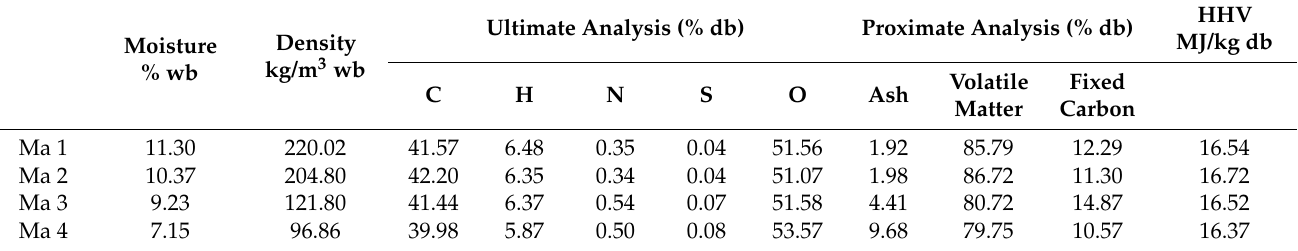
Table 1. Proximate and ultimate analyses (db: dry basis, wb: wet